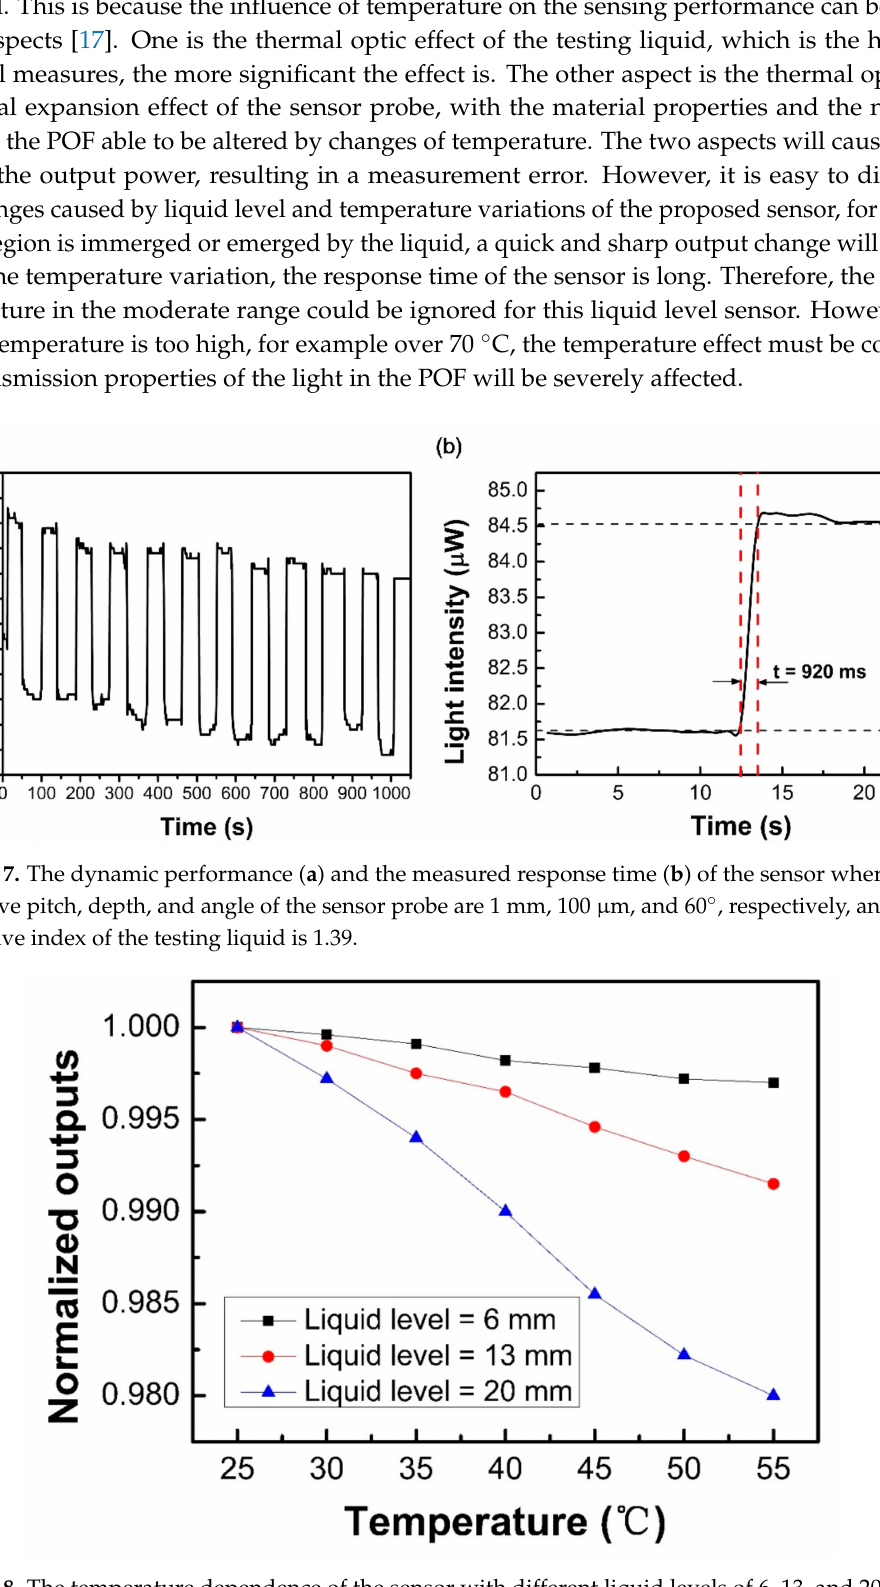
Figure 8. The temperature dependence of the sensor with different liquid levels of 6, 13, and 20 mm, respectively, where the refractive index of the liquid was 1.39 and the V-groove pitch, depth, and angle of the sensor probe were 1 mm, 100 µ m, and 60 ◦ ,